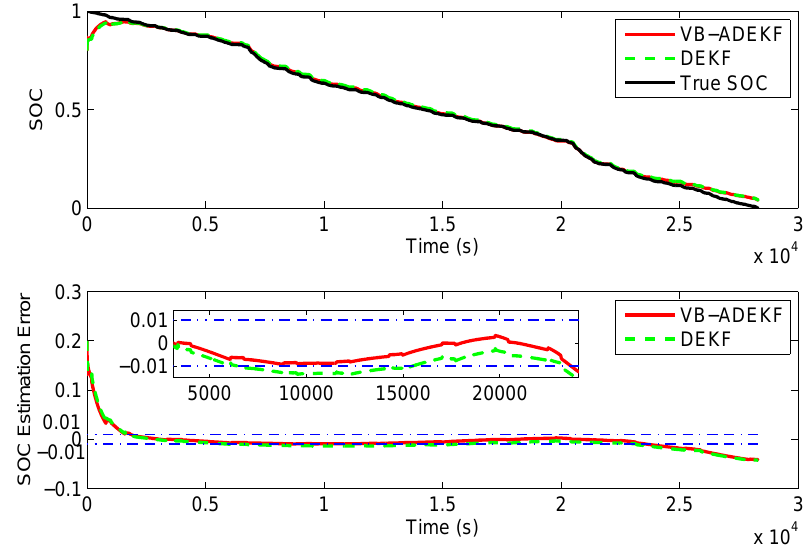
Figure 13. SOC estimation results using VB-ADEKF and DEKF in the UDDS